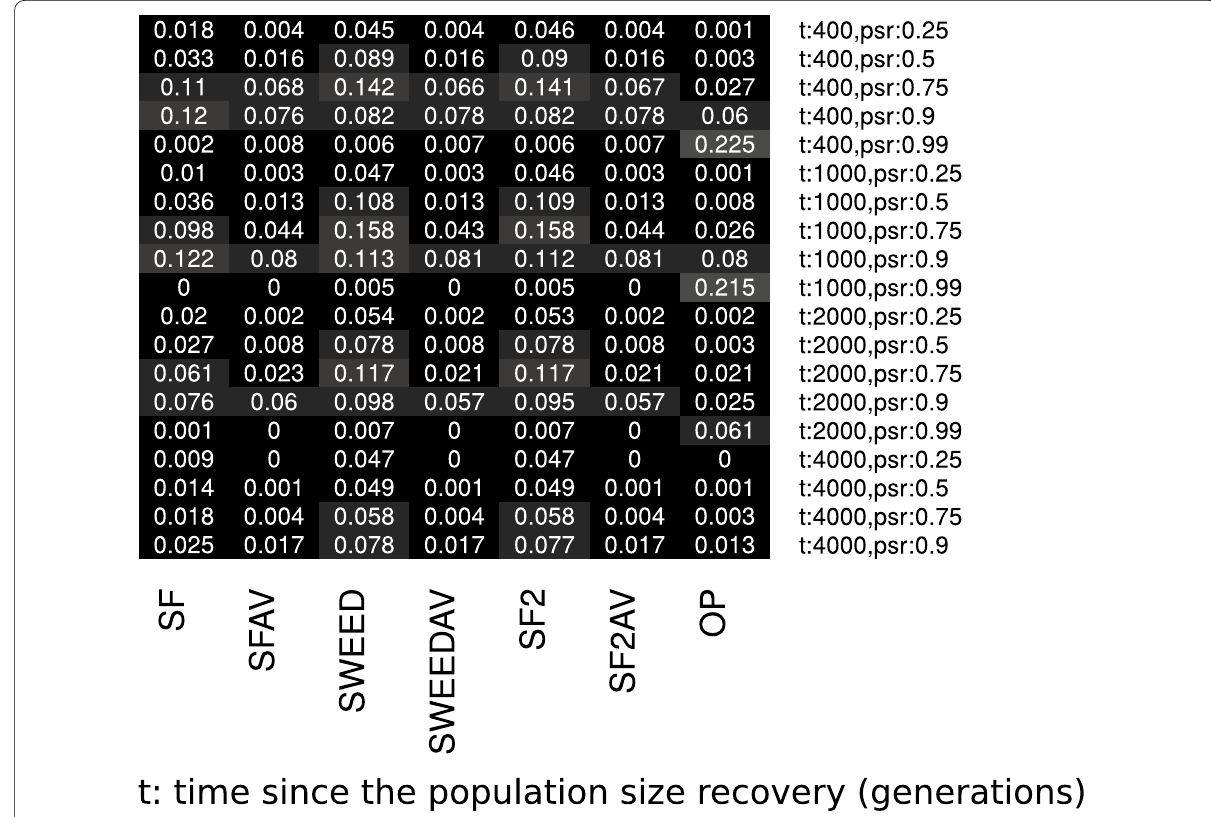
Fig. 5 False positive rates for the selective sweep detection process under various algorithms and demographic models when the demographic model used for the construction of the threshold value is a bottleneck model instead of an equilibrium model. To compute all threshold values, we have used the bottleneck model characterized by a population recovery at time t = 1000 generations, and bottleneck population size reduction by 0.90. The duration of the bottleneck was 4000 generations. FPR values have been reduced considerably compared to the case that the equilibrium model was used for the calculation of the threshold values (Fig. 4)